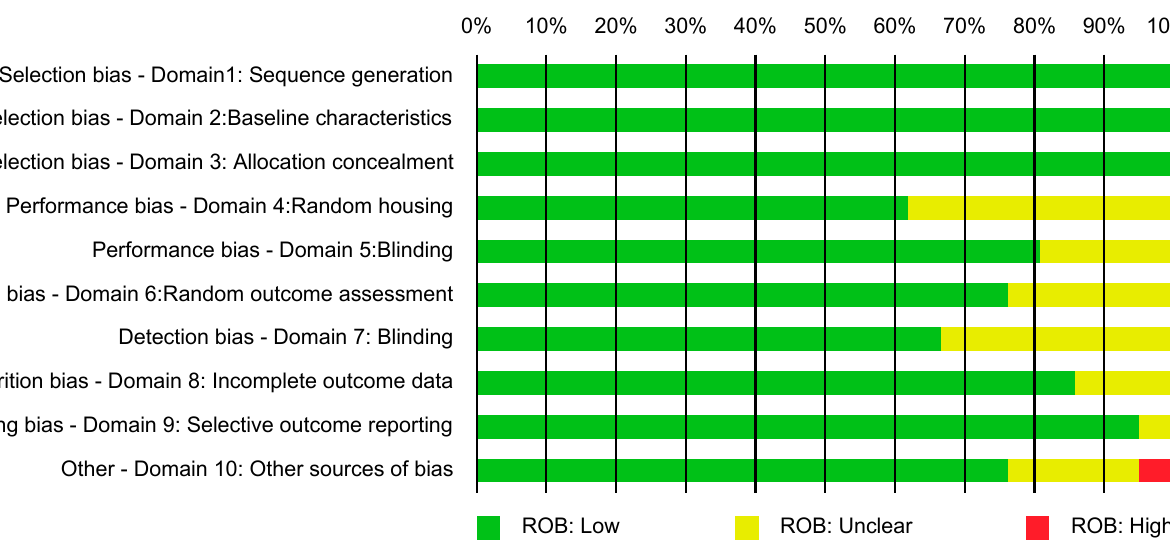
Table 2. Methodology of microscopic investigation in the included studies.